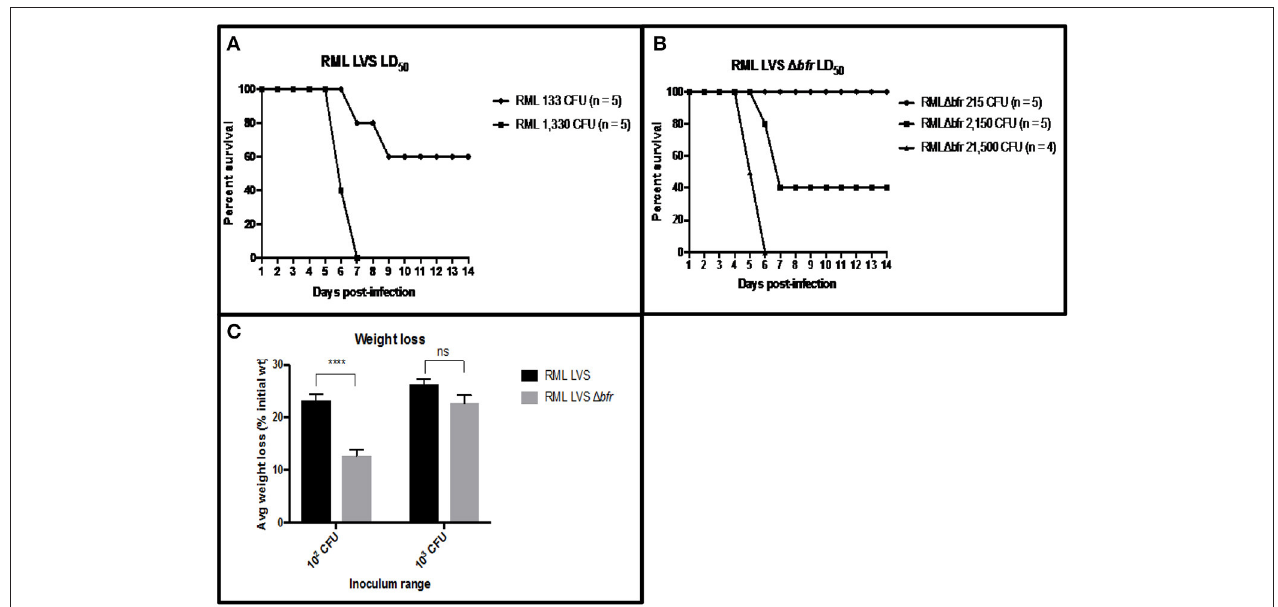
FIGURE 6 | Bacterioferritin is required for optimal RML LVS virulence and. (A) Groups of mice ( n = 5) were intranasally infected with 25 µ l inocula containing 133 or 1,330 CFU of RML LVS in PBS. Mice were weighed daily and humanely sacrificed after weight loss ≥ 25% of their initial weight. LD 50 values were calculated via the method of Reed and Muench (1938). (B) Groups of mice ( n = 5) were intranasally infected with 25 ul inocular containing 215, 2,150 or 21,500 CFU of RML LVS 1 brf in PBS. Mice were weighed daily and humanely sacrificed after weight loss ≥ 25% of their initial weight. LD 50 values were calculated via the method of Reed and Muench (1938). (C) The average weight loss of mice infected with 10 2 or 10 3 of the RML LVS strain or 10 2 or 10 3 of the RML LVS 1 bfr is represented by the bars in the graph. The significance of the weight loss of the mice infected with the RML LVS strain was compared to the weight loss of the mice infected with the RML LVS 1 bfr strain Mice infected with RML LVS were closer to or at clinical endpoint at all doses, while mice infected with RML LVS 1 bfr lost significantly less weight at the lowest infectious dose. Significance was set at p < 0.05. ****Indicates a significant difference between the two samples bracketed. Significance was tested via log-rank sum test.